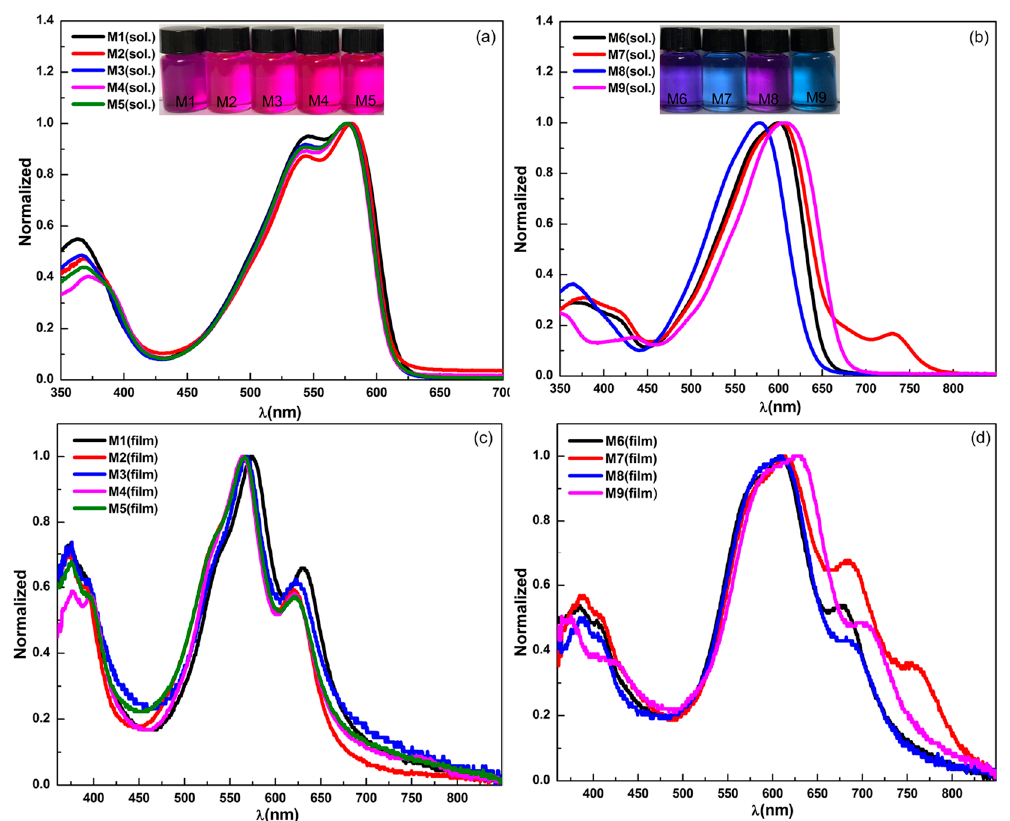
Figure 2. UV–vis spectra of meta -substituted phenyl-cored DPP molecules Ms1~5 and para -substituted phenyl-cored DPP molecules Ms6~9 ( b ) in CHCl 3 ( a , b ) and in films ( c , d ).